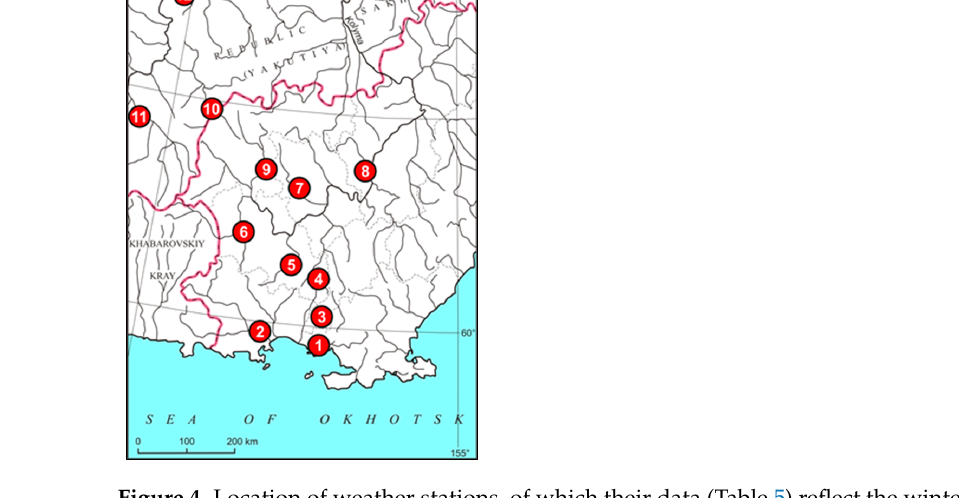
dropped below − 35 °C sixty times, below − 40 °C twenty-four times, and below − 45 °C five times, reaching a minimum for the winter of − 46.5 °C (Figure 5). The snow cover at the time of the onset of severe frosts (below − 30 °C) reached a thickness of about 35 cm in November 2019 and of more than 50 cm by the end of January 2020 (Figure 5).